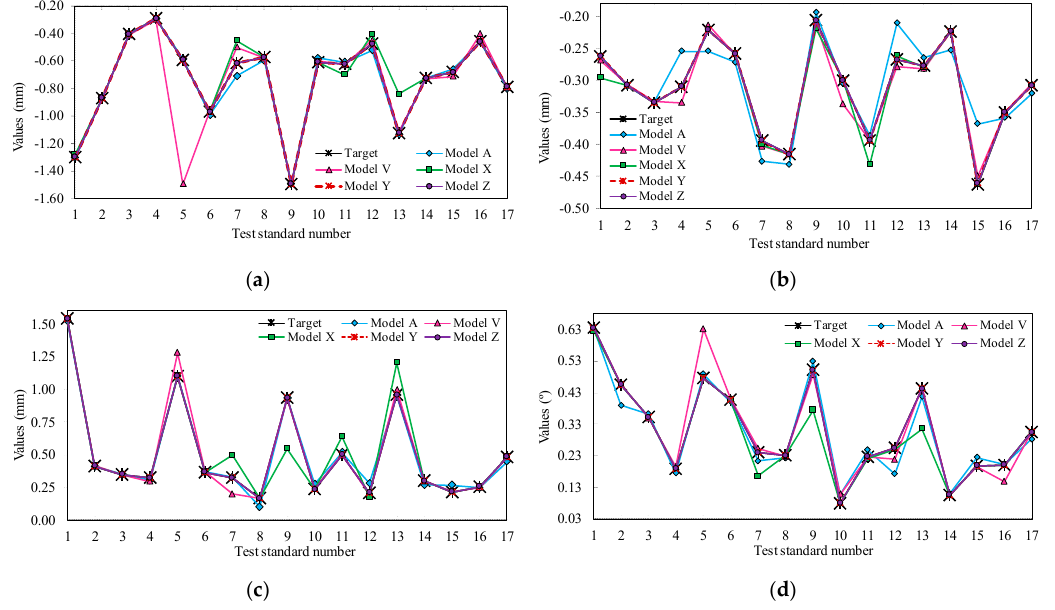
Figure 5. Performance analysis of multi-criteria ANN models—type of deviations vs. predicted values of models vs. target value: ( a ) predicted values of models vs. target values of dimensional deviation height; ( b ) predicted values of models vs. target values of dimensional deviation of the diagonal length; ( c ) predicted values of models vs. target values of geometric deviation of the flatness; ( d ) predicted values of models vs. target values of geometric deviation of the side angles.